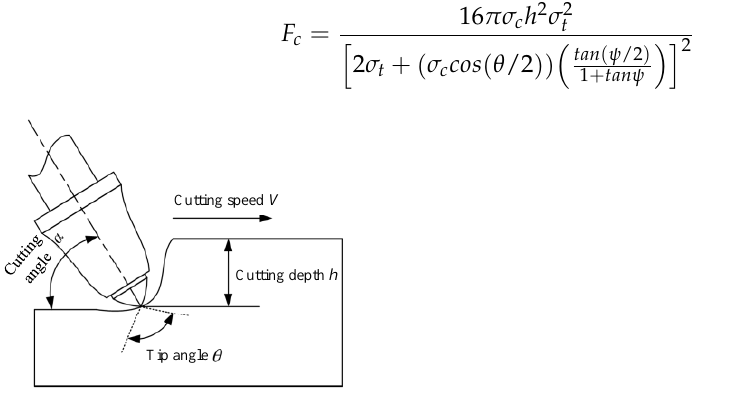
Figure 1. The conical pick rock-cutting model.